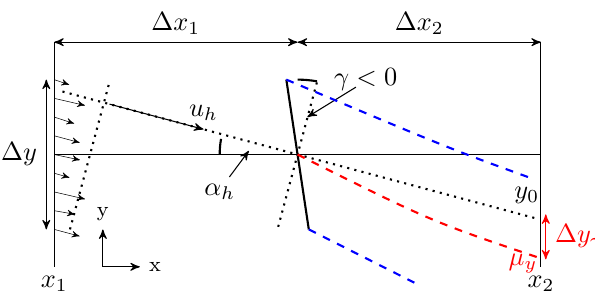
Figure 1. Conceptual image of the method to calculate the wake deflection (cid:49)y γ ( x 2 ) by using the inflow wind direction α h ( x 1 ) of the wind speed u h ( x 1 ) at hub height and the position of the wake center µ y ( x 2 ). Here, the x axis is the mean wind direction. The yaw angle γ is defined relative to α h , with γ > 0 for a clockwise turning of the rotor. Inflow wind speed and direction are averaged along (cid:49)y